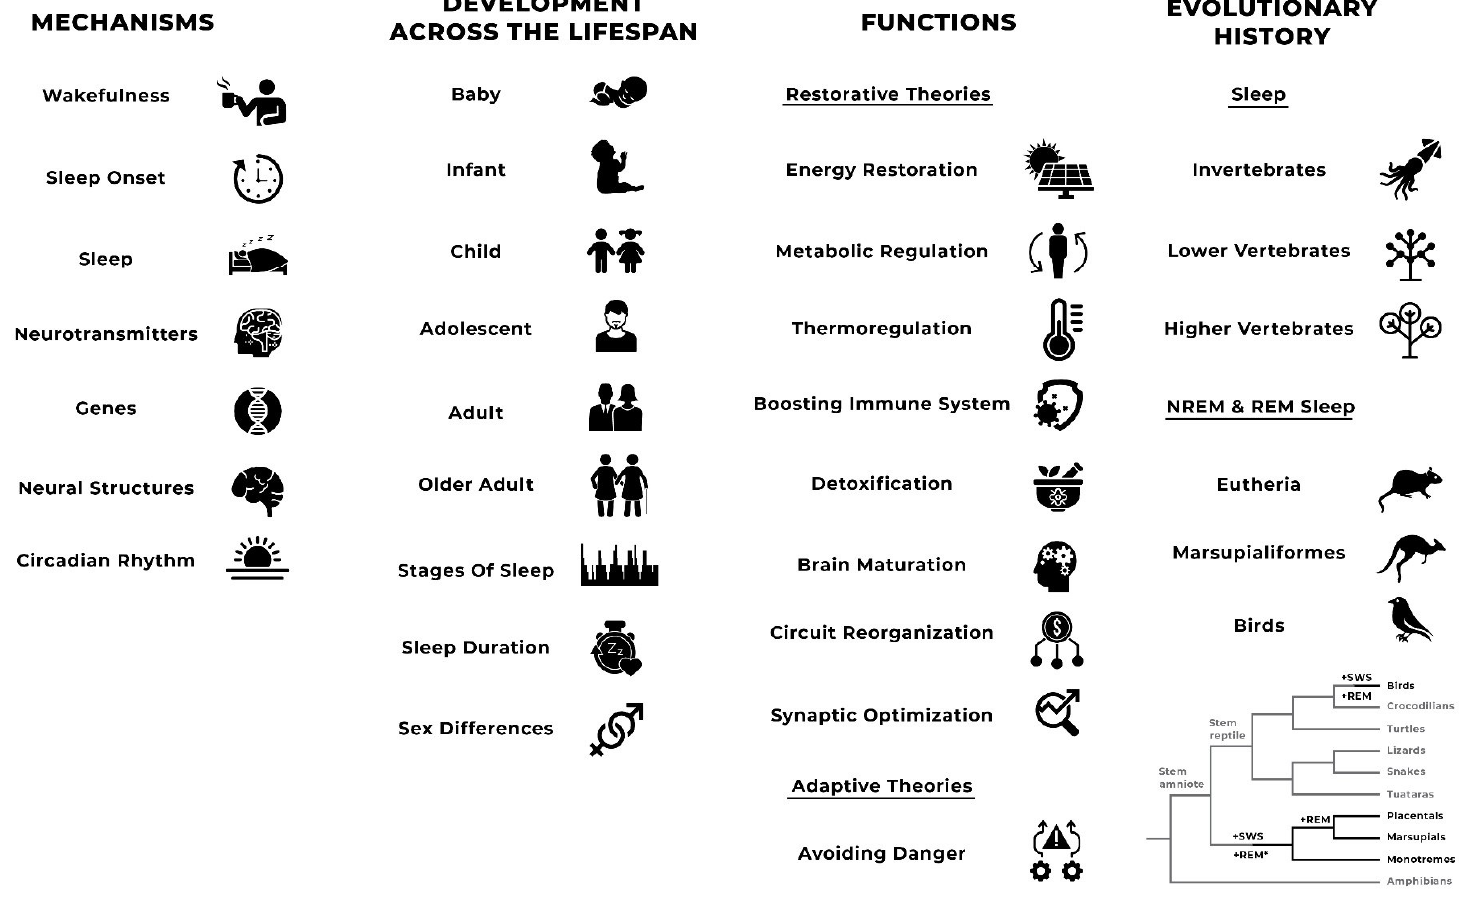
Figure 1. List of features of sleep according to Tinbergen’s four questions. Features of sleep are presented according to the order in which they are presented in this article. Cladogram taken from Lesku and colleagues [56]